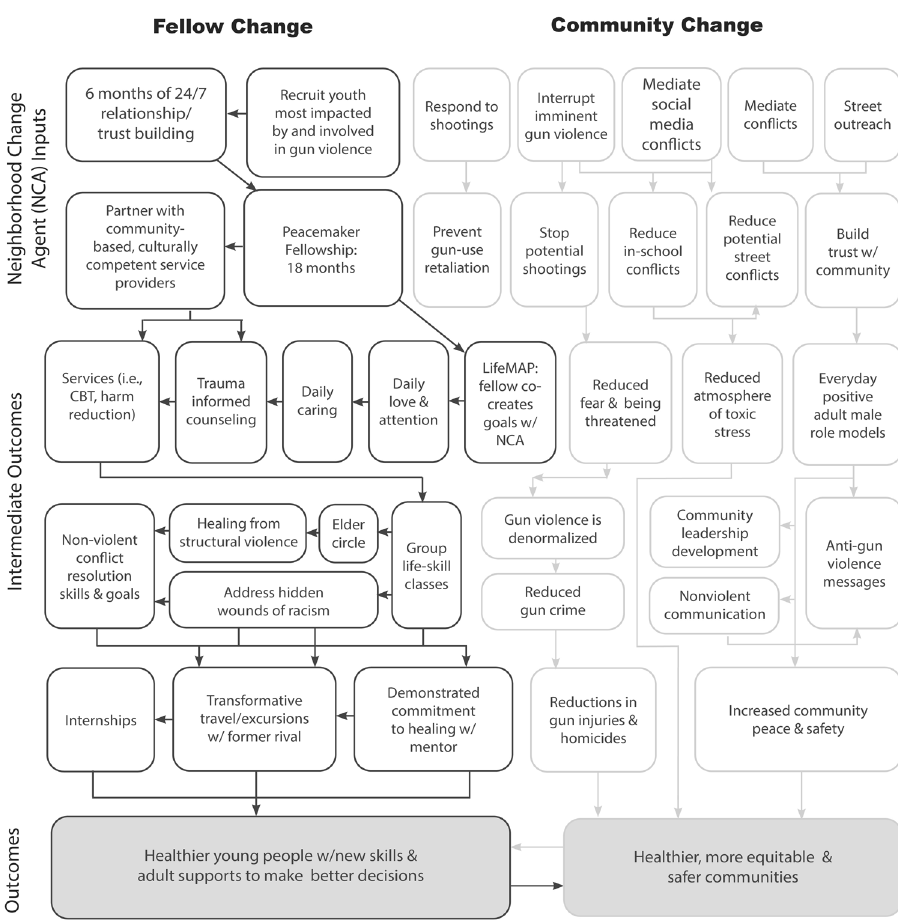
Fig. 1 The Advance Peace Model of Healing and Transformative Change. The left columns reveal the relationships between Advance Peace outreach worker supports, programs and services that combine to help heal individuals. The right columns reveal how these same and related program components support community healing and transformation.